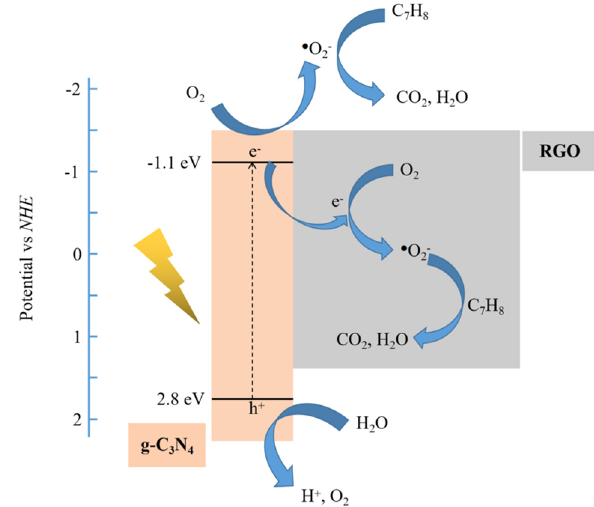
Figure 11: PL spectra of GC and GC - RGO - 1.5. Figure 12: The photocatalytic degradation mechanism for gaseous toluene.